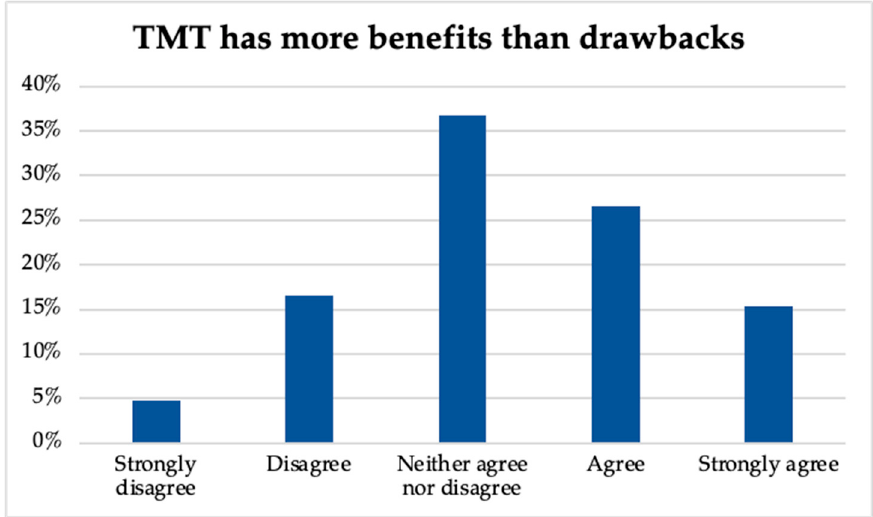
Figure 2. TMT benefits vs. drawbacks.